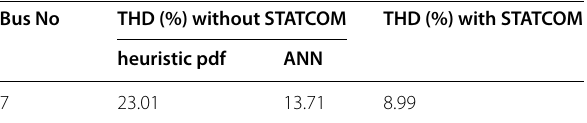
Table 24 THD of real power flow with and without STATCOM of IEEE 9- bus system at bus 7